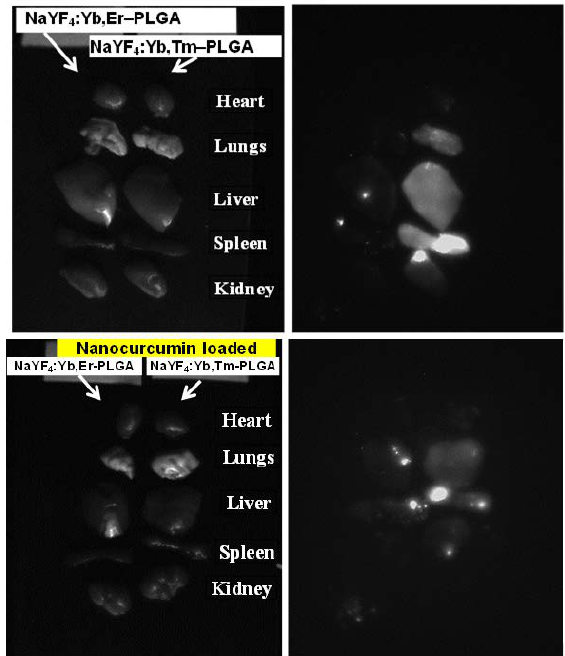
Figure 15. Bright-field image of the ex vivo organs ( left ) and epiluminescent image of the mouse organocomplex ( right ). Intravenous injection of 0.75 mg UCNPs, 4 h after injection. (Upper row-NaYF 4 :Yb,Er-PLGA and NaYF 4 :Yb,Tm-PLGA, lower row-NaYF 4 :Yb,Er-PLGA-nanocur and NaYF 4